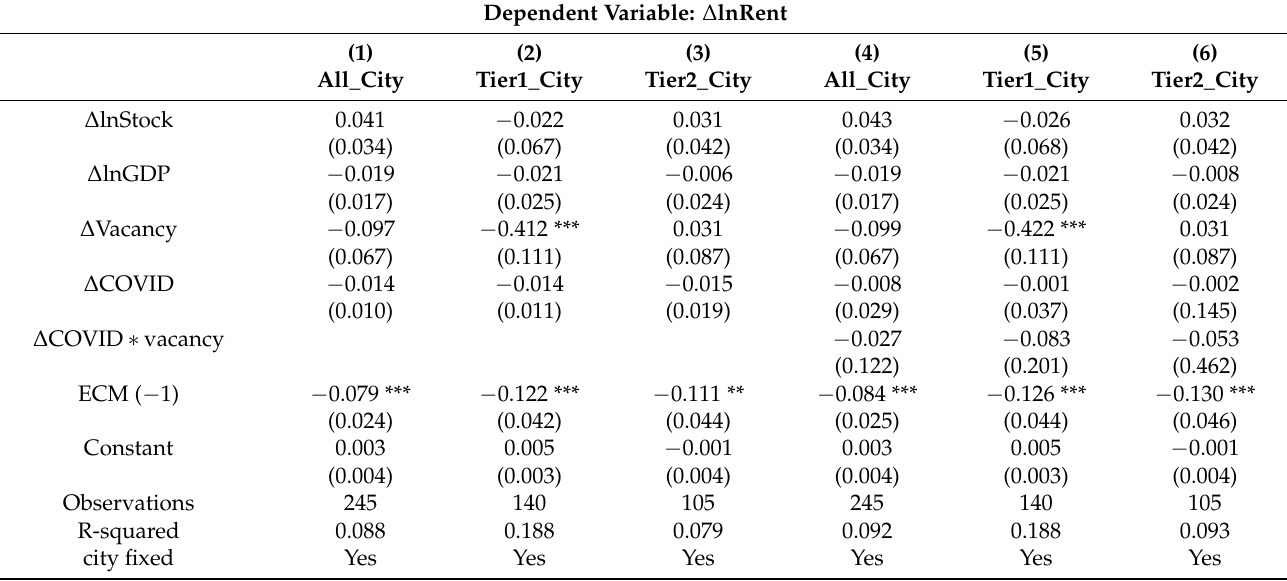
Table 5. Office rent short-term